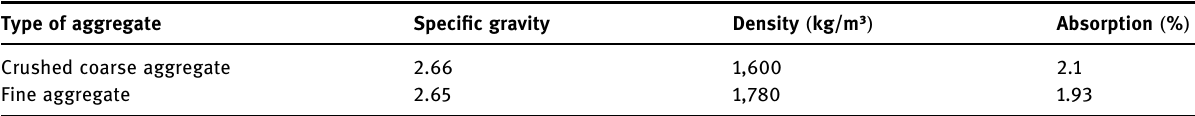
Table 1: Properties of course and fi ne aggregate